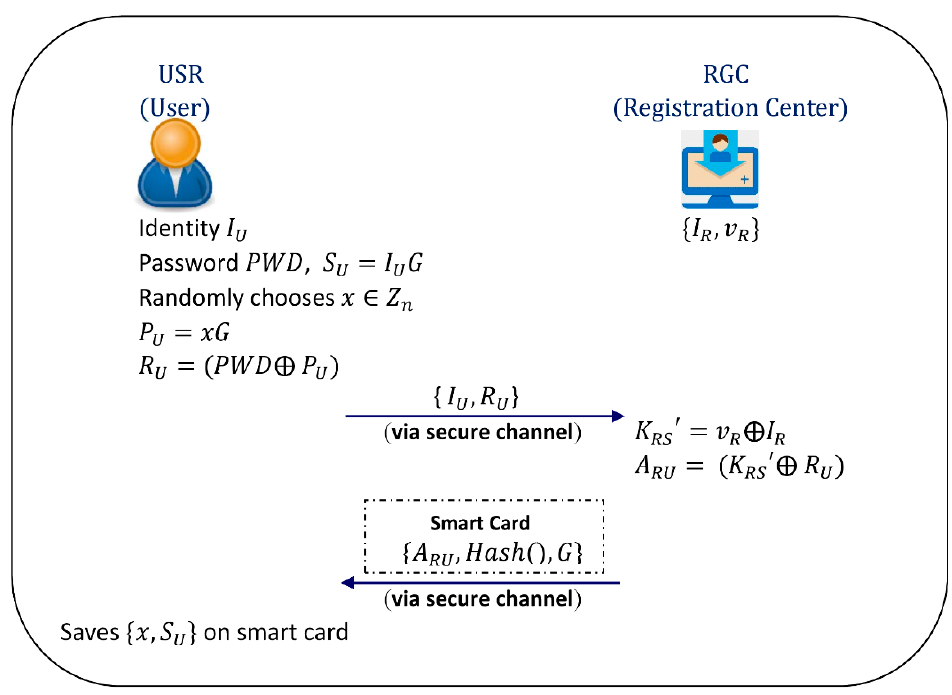
Figure 5. Registration of 𝑈𝑆𝑅 with 𝑅𝐺𝐶 in ECSSP-SC.